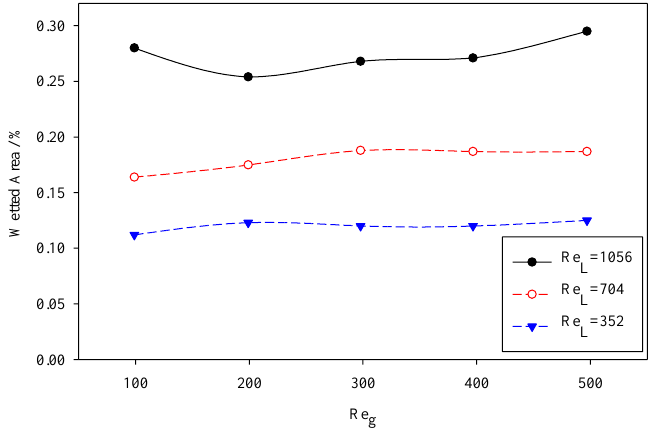
Figure 8. Influence of gas velocity with fixed liquid velocities on wetted area.